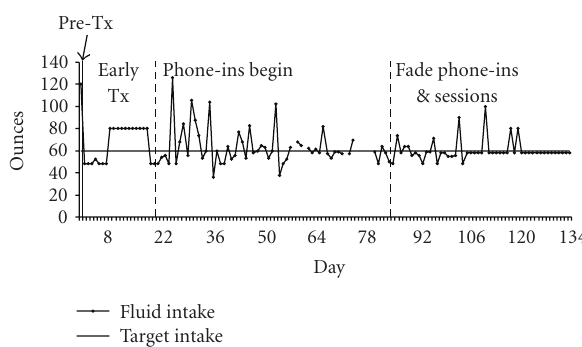
Figure 1: Patient’s daily fluid intake levels from pretreatment to termination. Note: breaks in the graph indicate days when fluid intake level was not